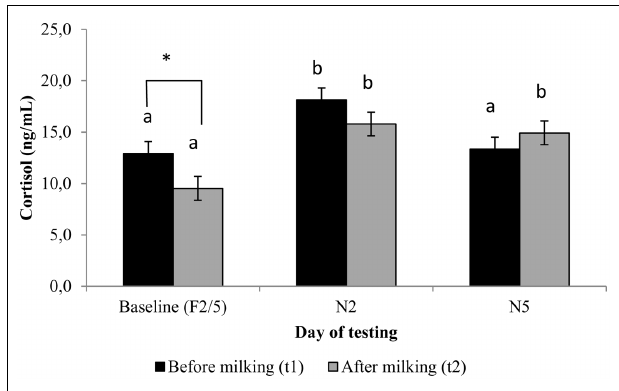
FIGURE 1 | Serum cortisol concentrations (ng/mL; least square means ± SEM ) of cows ( n = 20) before and after being milked in a familiar (Baseline) and novel milking environment (N2 and N5). ab Within sample collection time, least square means with different superscripts differ at p < 0.05. Means accompanied by an * differ at p <